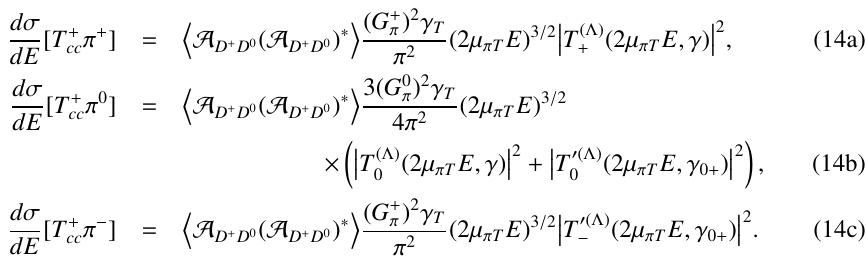
π + (left cc π 0 (right red cc are cc . The △ a